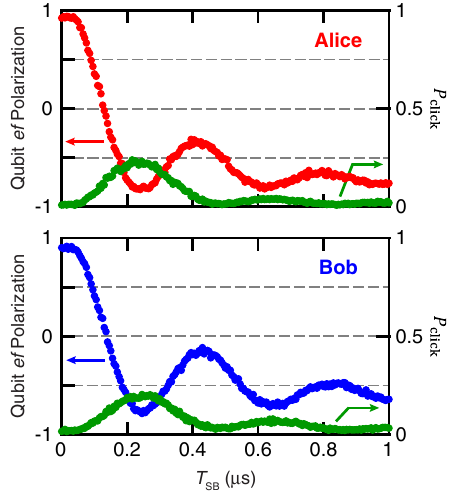
FIG. 7. Single-photon generation with sideband transitions. Alice (top) and Bob (bottom) qubit ef polarization (left axis) and detector click probability P (right axis) as a function of click sideband pulse length T , when the qubit is prepared in j f i . Two SB sideband drives ( ω , ω ) were applied, satisfying the QSB CSB − ω ω e − ω frequency condition ω . The drives ef CSB QSB ¼ A=B result in coherent oscillations between j f 0 i and j e 1 i , with the amplitude of the drives chosen such that a π -pulse on the transition takes the same time for the Alice and Bob qubits, 254 ns. The generation of a photon was verified with the T SB ¼ detector, which showed a peak in P when Alice or Bob click were in j e i